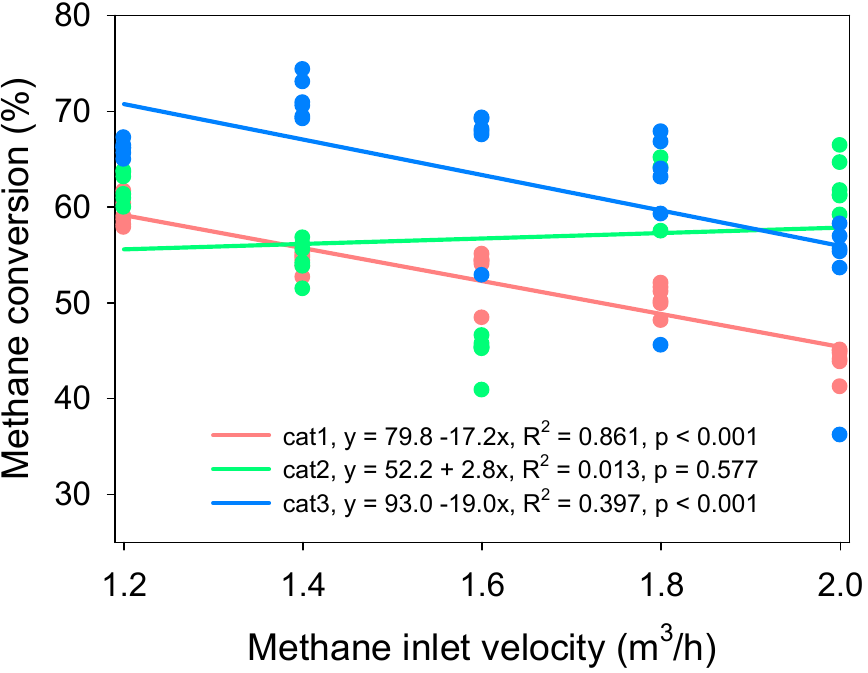
Figure 6. Correlation of methane inlet velocity and methane conversion. Start-up conditions: switch frequency: 5 min, reaction temperature: 800 °C, methane inlet concentration: 0.7%.